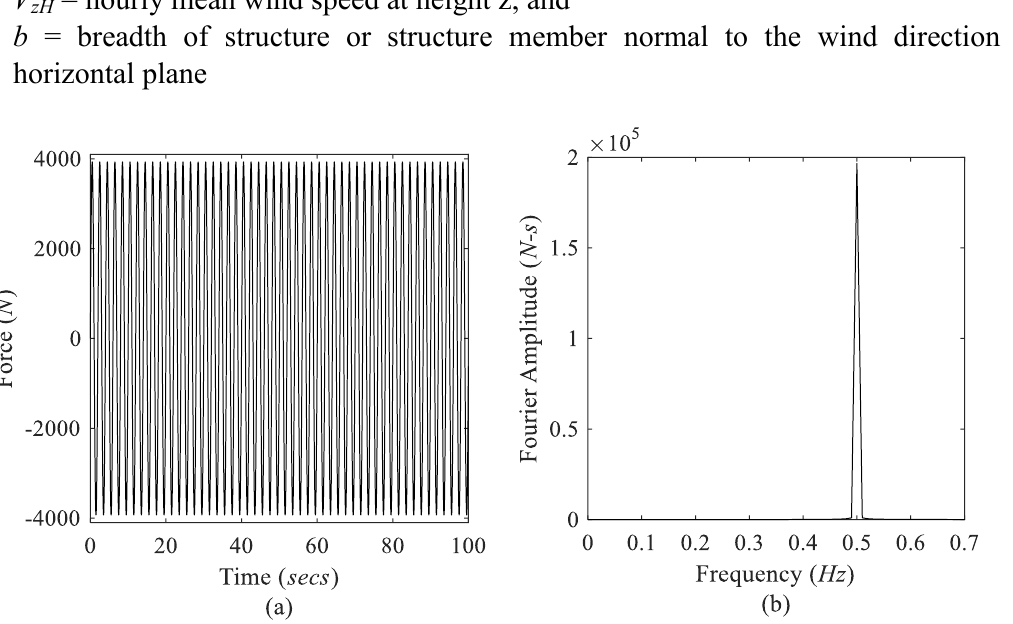
Fig. 8. (a) Time history of vortex shedding induced load at top floor (b) Fourier spectrum of vortex shedding induced load at top